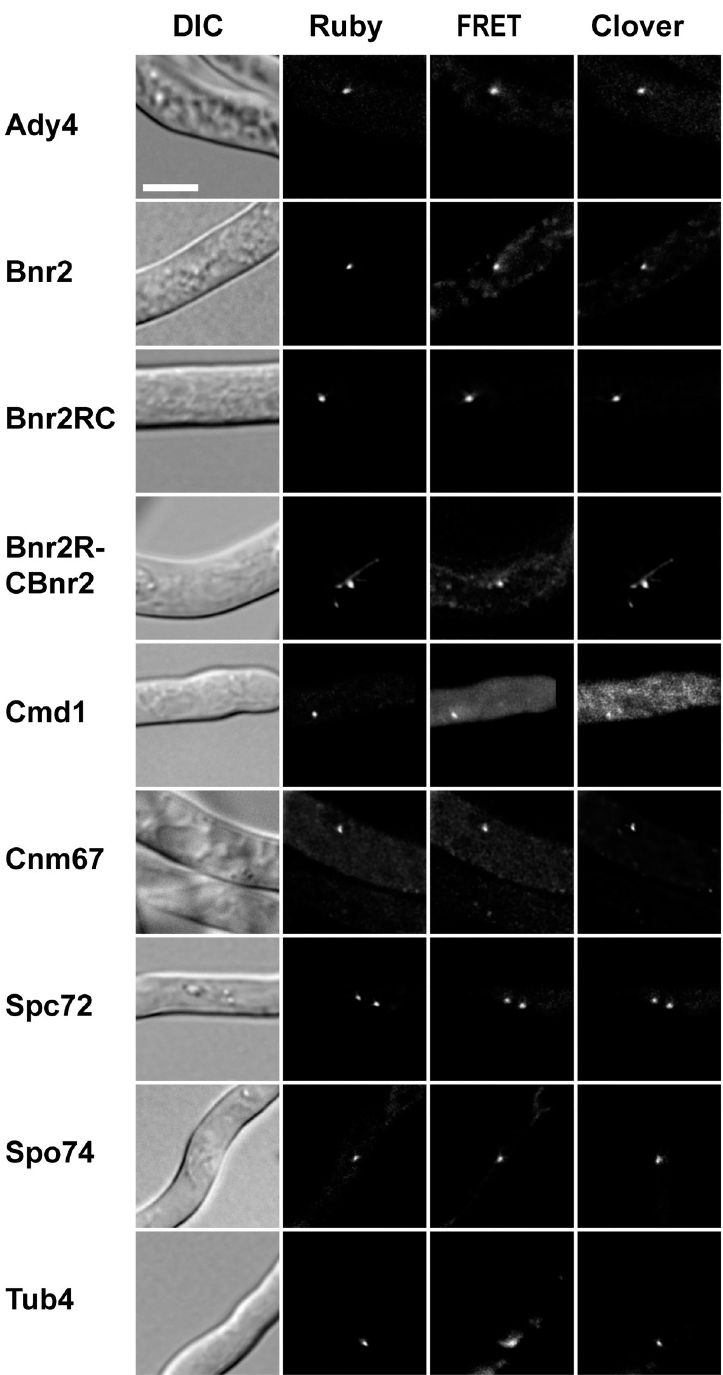
Fig 1. Sample images of each strain used for FRET-measurements. The indicated proteins of each strain are labeled at the carboxy-terminus with yomRuby2 and carry an additional episomal copy of AgBnr2 labeled with yoClover also at the carboxy-terminal end, except for AgBnr2RC and AgBnr2RCBnr2 that carry both labels on a single protein. Note that the intensity of the fluorescent signals is scaled for visibility and does not reflect the intensity measured, especially in the FRET channel. The scale bar represents 10 μ